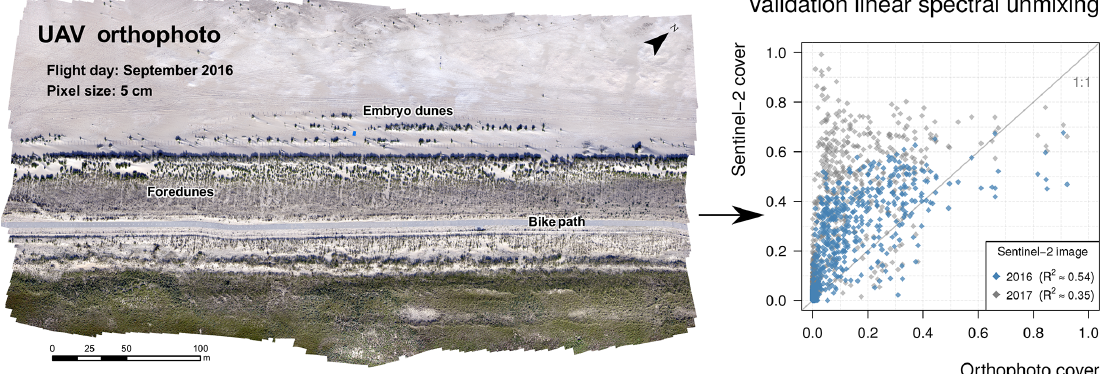
Figure 3. Validating the linear spectral unmixing procedure on the Sentinel-2 images using an orthophoto (5cm pixel size) derived in September 2016 by an unmanned aerial vehicle (UAV). Linear spectral unmixing produces a systematic overestimation of subpixel propor- tions of marram grass cover compared to the cover values calculated from the orthophoto. A positive linear regression model explains 54% of the variance for the 2016 Sentinel-2 image and 35% of the variance for the 2017